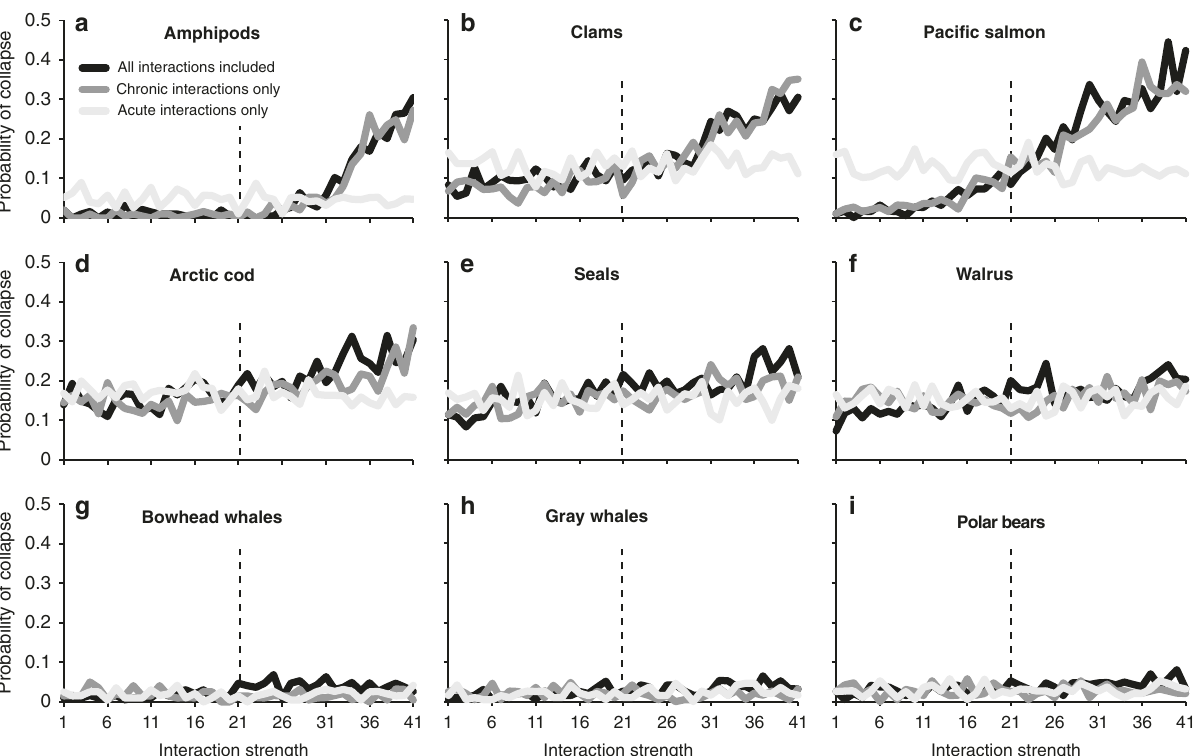
Fig. 4 The probability of population collapse plotted as a function of interaction strength. Included are ( a ) amphipods, ( b ) clams, ( c ) Paci fi c salmon, ( d ) Arctic cod, ( e ), seals, ( f ) walrus, ( g ) Bowhead whales, ( h ) Gray whales, and ( i ) polar bears. A separate set of simulations was run with only acute stressor interactions included, only chronic stressor interactions included, and all stressor interactions included. The dashed line represents the baseline interaction